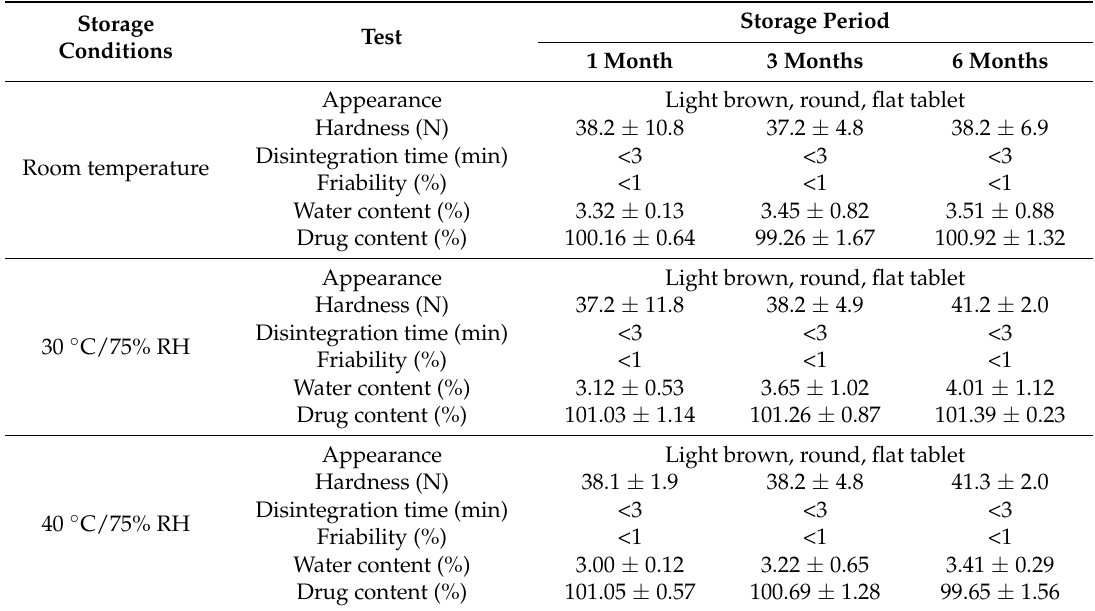
Table 5. Of the albendazole self-microemulsifying chewable tablet (F2) stored at 30 ◦ C/75%